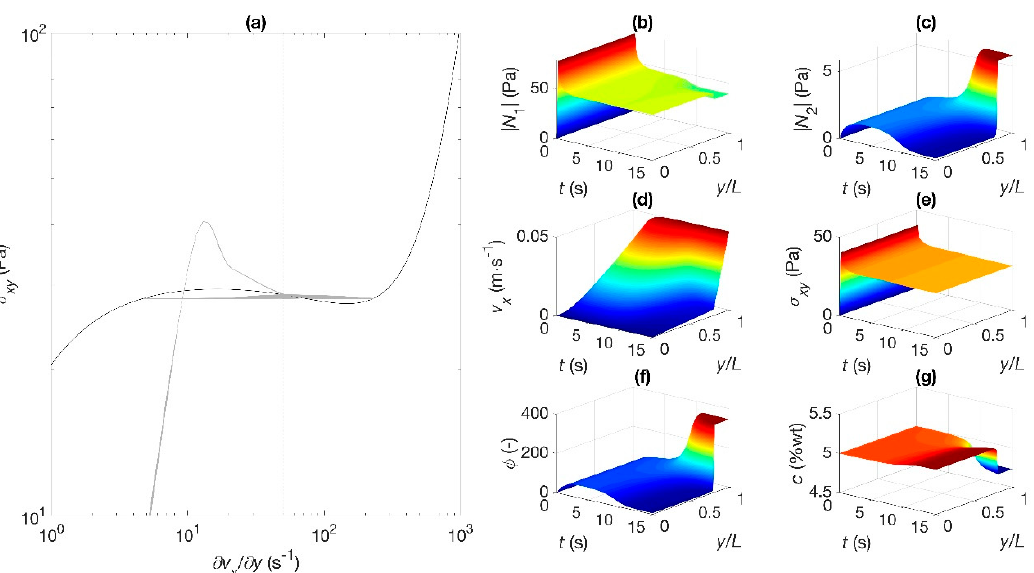
Figure 4. Dynamics and steady state under controlled shear rate. Reference shear rate is 50 s − 1 . Temporal trajectory of the stress and shear rate for various spatial positions ( a ), evolution of the normal stress differences N 1 ( b ) and N 2 ( c ), velocity ( d ), shear stress ( e ), fluidity ( f ), and concentration ( g ), in space and time.